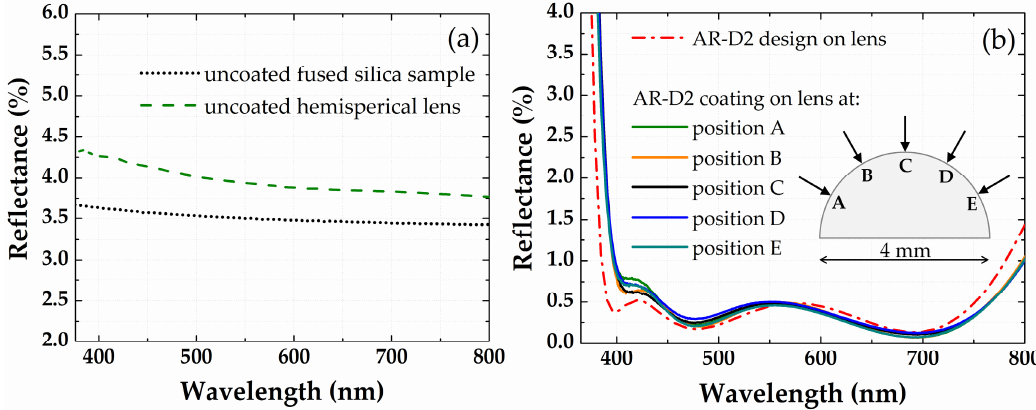
Figure 5. ( a ) Measured reflectance spectra of uncoated fused silica reference glass substrate and uncoated fused silica half ‐ ball lens; ( b ) Measured reflectance spectra (AOI = 0°) of AR ‐ coated fused silica half ‐ ball lens at different positions of the lens.